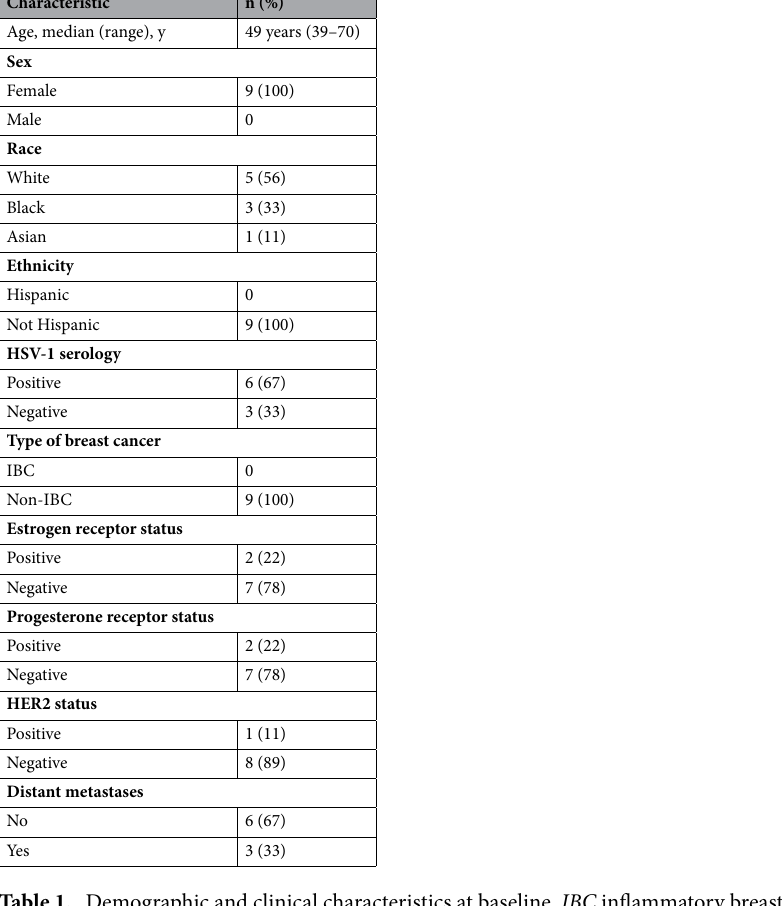
Table 1. Demographic and clinical characteristics at baseline. IBC inflammatory breast